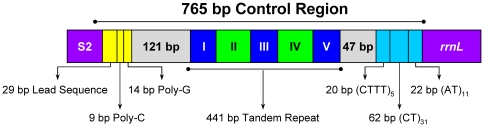
Organization of the mitochondrial control region of Stenopirates sp.The control region flanking genes trnS2 (S2) and rrnL are represented in purple boxes. The blue and green boxes with roman numerals indicate the tandem repeat region; grey boxes represent the stem-loop region.